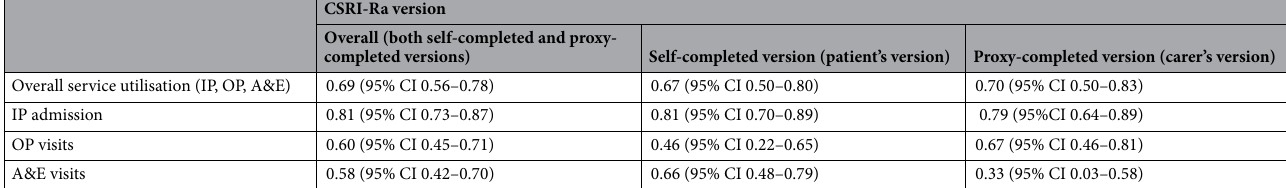
Table 4. External validity between CSRI-Ra versions and ePR using intra-class correlation coefficient. A&E accident and emergency, CI confidence interval, CSRI‑Ra Client Service Receipt Inventory for RAre genetic disease population, ePR electronic patient record, IP inpatient, OP